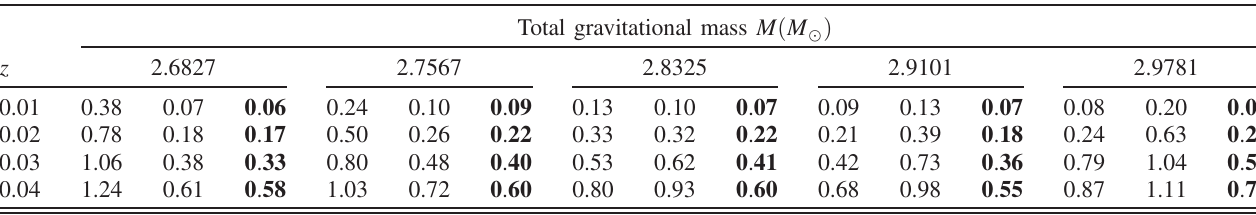
TABLE V. The percentage measurement uncertainties on the total gravitational mass of a BNS source. We show results for each of our five different mass systems and for each of four different redshifts. The details are identical to those given in Table IV.